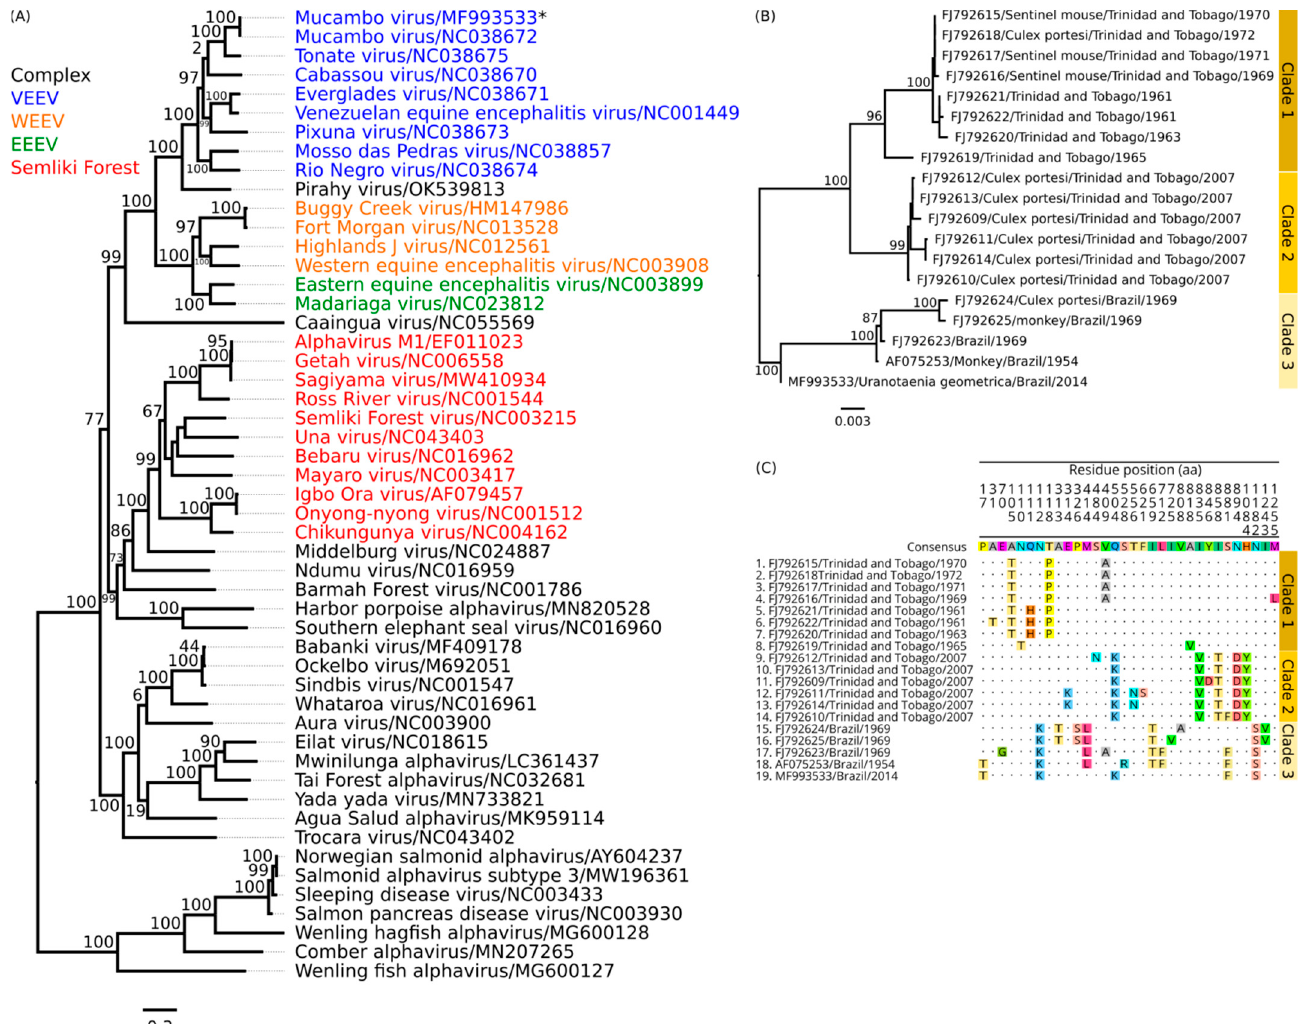
Figure 3. Analyses using different sequences of Alphavirus. ( A ) Phylogenetic tree of different RefSeq Alphaviruses using the Maximum Likelihood (ML) based on the complete nucleotide sequences of a non-structural polyprotein. The GTR + F + I + G4 distribution was the best-fit model defined for this dataset. The tips of the tree correspond to the NCBI ID/Strain/Host/County/Year of each sample. ( B ) Phylogenetic tree using partial nucleotide sequences of structural polyprotein of a region with 3777 nt. Three monophyletic groups are identified. For both trees, the numbers at each main node of the tree correspond to bootstrap values in percent (1000 replicates). The scale bar corresponds to genetic divergence among nucleotide sequences. ( C ) Amino acid alignment of the non-structural polyprotein, including only non-synonymous mutations, and the position in the top image correspond to the position in the MF993533 sequence available in the NCBI.